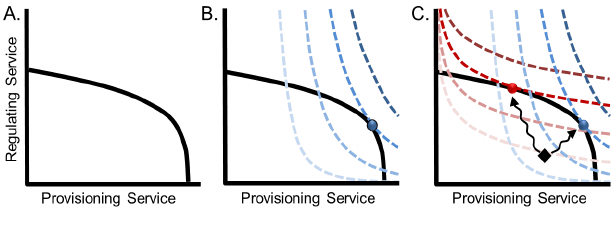
Fig. 1 . Trade-off diagrams representing the basic steps of the analytical framework of Cavender-Bares et al. (2015). A. Black curve represents the production possibility frontier (PFF), or maximum sustainable rendering of regulating service (y-axis), for each level of provisioning service (x-axis) rendered. B. Blue dashed curves are isoclines or indifference curves of stakeholder utility values, with darker lines representing greater utility. The blue point represents the maximum sustainable utility that the stakeholder can garner, given the biophysical constraints that define the PPF. C. Red and blue dashed lines are utility indifference curves shown for two different stakeholder groups; red and blue points represent each group’s goals for optimal utility. The black diamond represents the current levels of each ecosystem service being rendered in the system. The wavy arrows represent two potential trajectories for changing the levels of services rendered. Each pathway increases utility of one stakeholder group but decreases utility for the other. (Redrawn and modified from Cavender-Bares et al. 2015 with